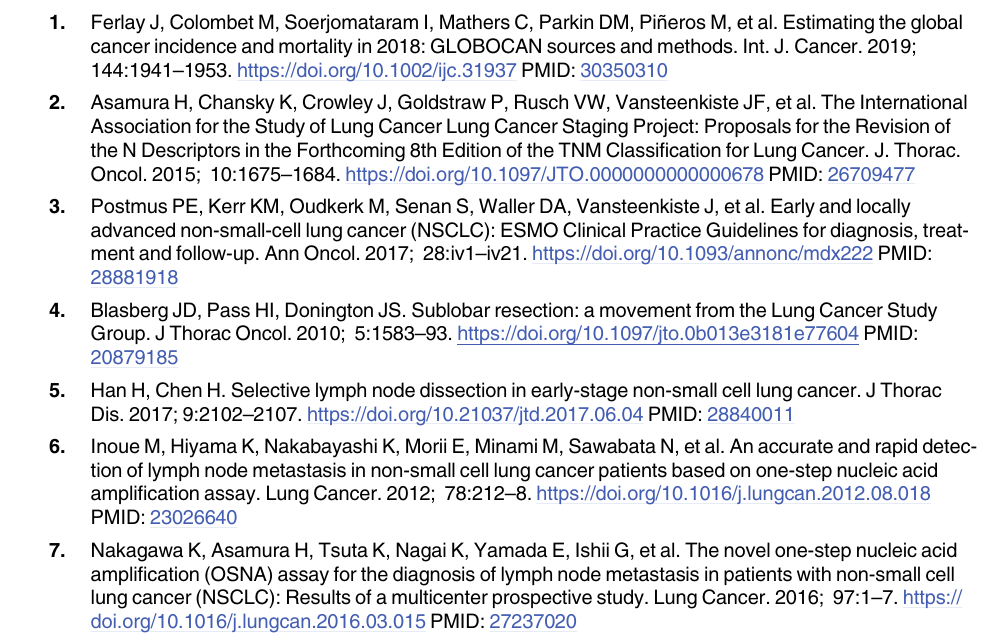
S1 Table. Cytokeratin19 expression in primary tumor among 16 cases.